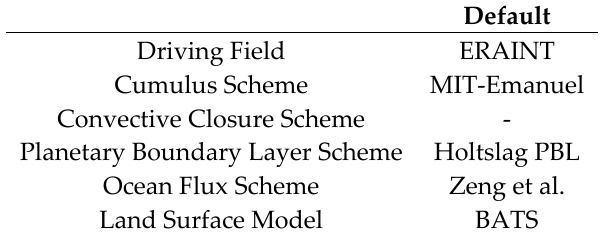
Figure 2. Land cover of BATS Land Surface Model and CORINE 2000 Land Cover Project. Table 2. The initial configurations of the model used as “Default”